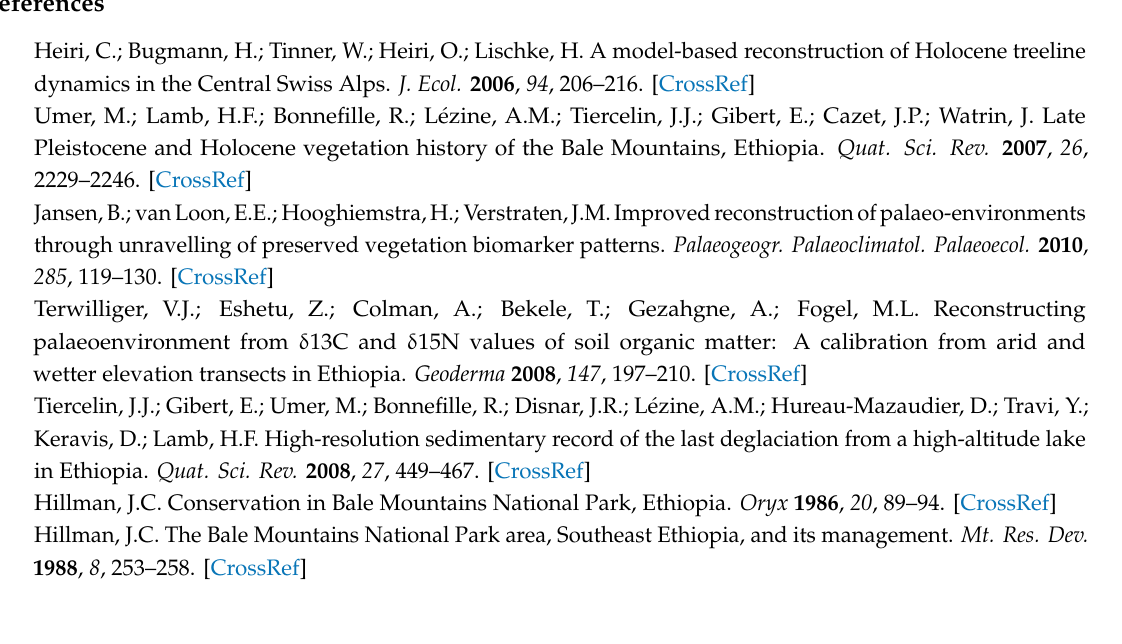
Figure S1: Comparison of Accuracy (A) and F1 Score (B) of Support Vector Machine (SVM, blue), Random Forest (RF, red) and Recursive Partitioning (RP, grey) algorithm based on the level of relative phenols, in relation to the ratio of tested / total number of samples (n = 47) that has been split into test and training datasets, each model has been computed 5 times, the bars indicate the standard derivation between the prediction results of the models; Figure S2: Principal Component Analysis, PCA based on the relative phenol abundance in 47 leaf and twig samples from the Bale Mountains, shown are the first two principal components (PC1 and PC2). Dark red arrows indicate the direction of each vector of feature; Figure S3: Cross-validation of the model used; Table S1: Sum of weighted mean of phenolic compounds of each dominant plant